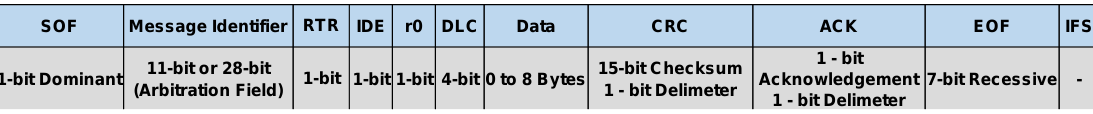
Figure 2. Classical CAN frame structure.